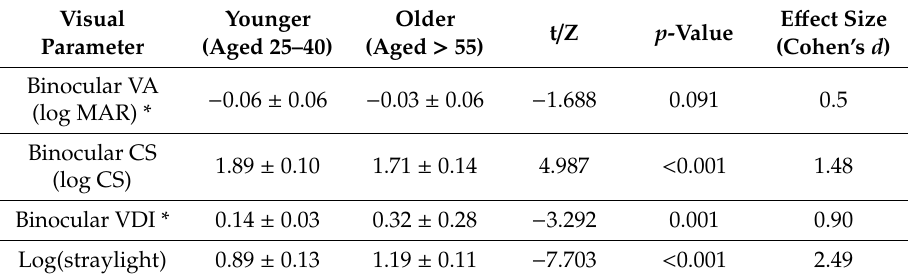
Table 2. Comparison of visual function measurements for the two age